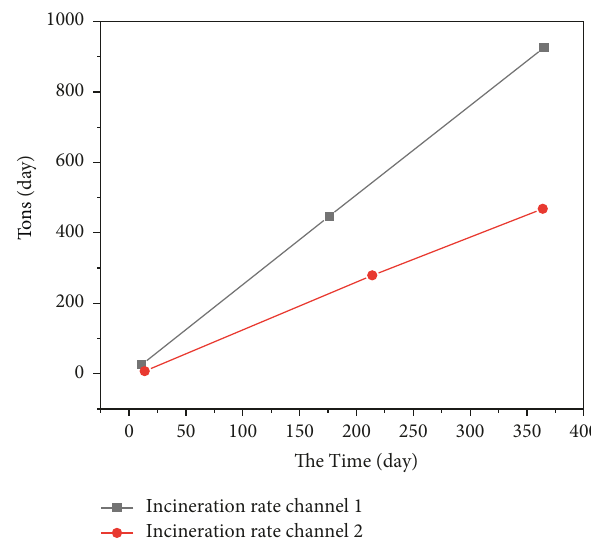
Figure 5: Nonreusable waste incineration rate comparison.